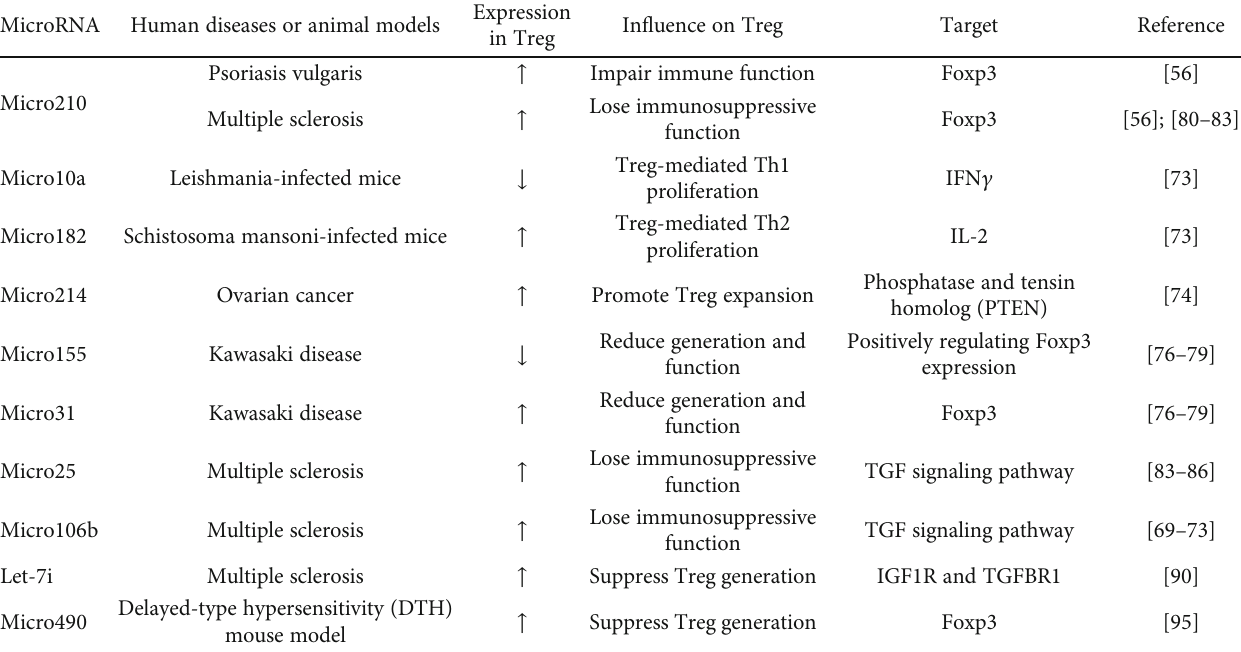
Table 1: Altered expression of microRNA in Tregs in immune-related